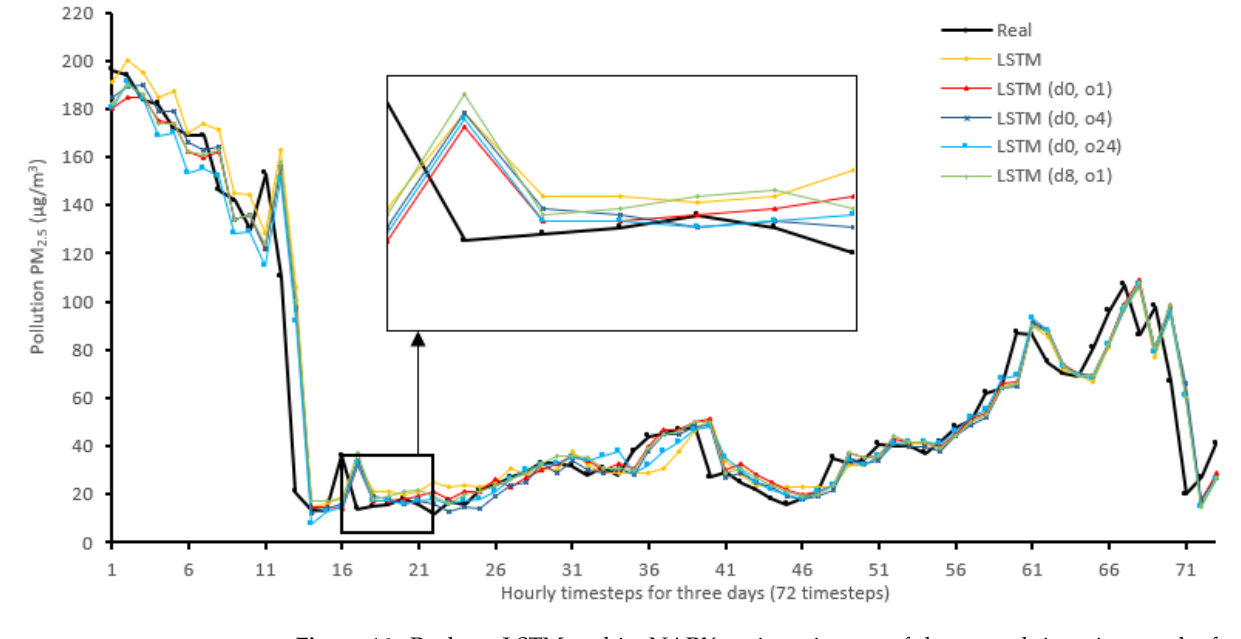
Figure 16. Real vs. LSTM and its NARX variants in part of the seventh iteration results for the Beijing dataset.